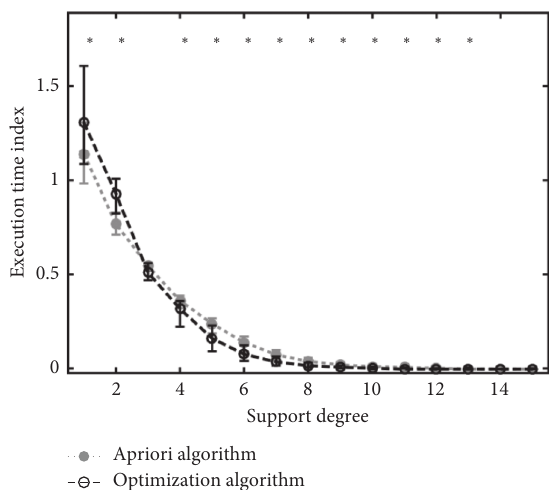
Figure 1: Comparison of the execution time of two algorithms with different supports.